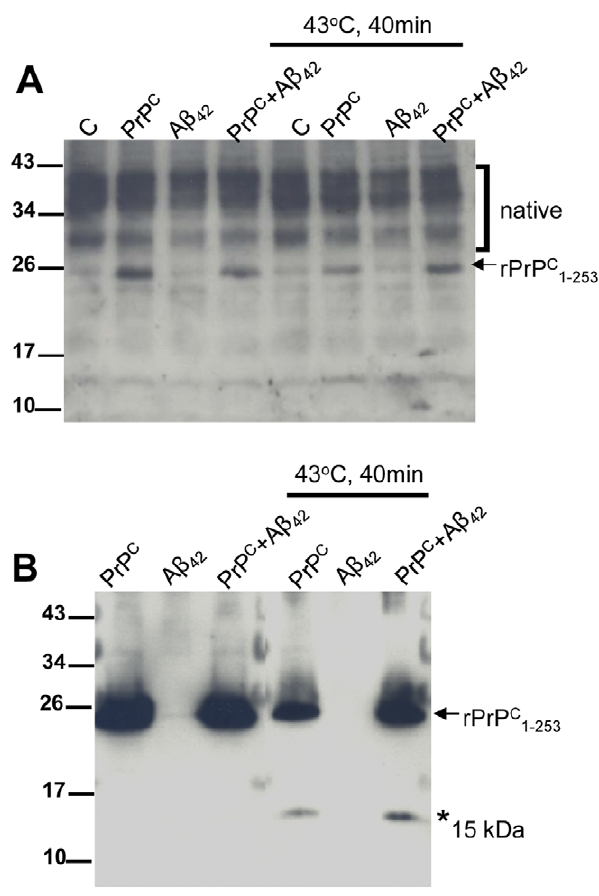
Figure 3. PrP C associates with CAD cells. ( A ) CAD cells were incubated with 3 m M A b 42 and/or 0.5 m M bovine rPrP C , after , 42 hours cells were subjected to heat-shock at 43 u C for 40 minutes and then allowed to recover for 5 hours. The cells were rinsed in PBS and lysed. 30 m g of the soluble protein or 10 m l of the insoluble fraction was resolved by SDS-PAGE and cellular PrP C was determined by Western analysis. ( B ) Purified rPrP C was added to DMEM/F12 tissue culture media, subjected to heat-shock (43 u C for 40 minutes) and then incubated at 37 u C for 48 hours in the absence of cell lines and dissolved directly in sample